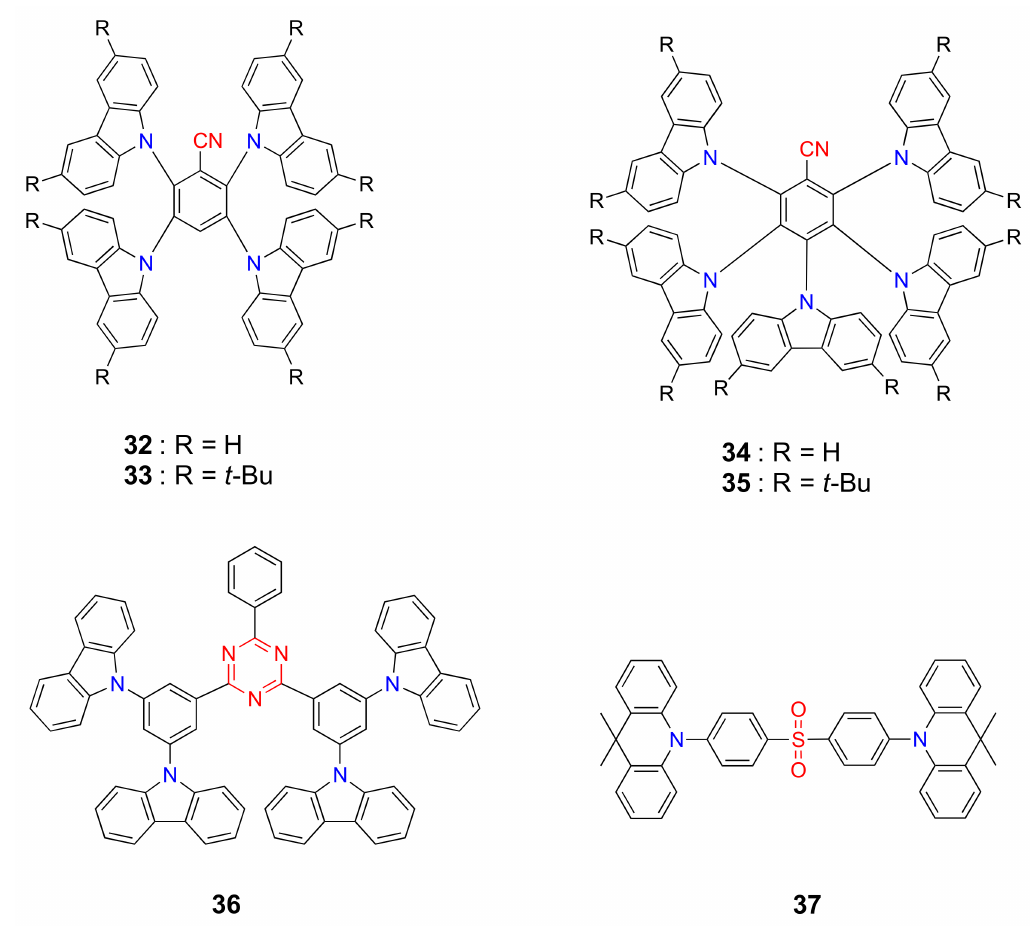
Figure 10. TADF emitters examined for the device